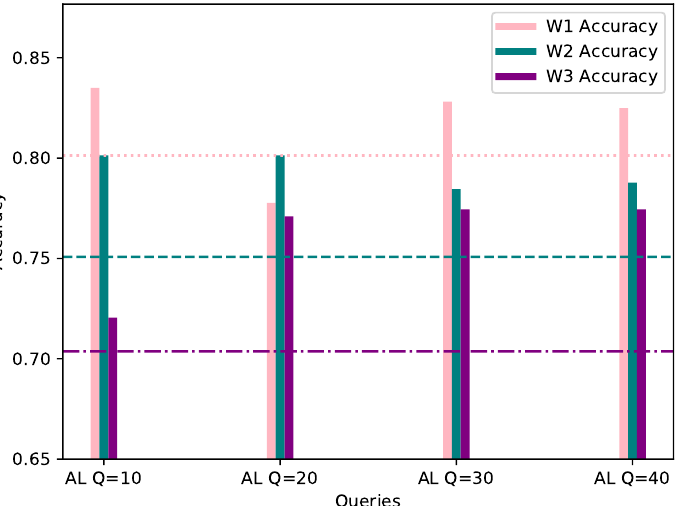
Figure 8. Accuracy of W1, W2 and W3’s models personalized with 70% AL dataset bias ( Y -axis) per Query ( X -axis), evaluated using their corresponding evaluation datasets. The FL accuracy for each worker is represented by the horizontal line of the worker’s respective